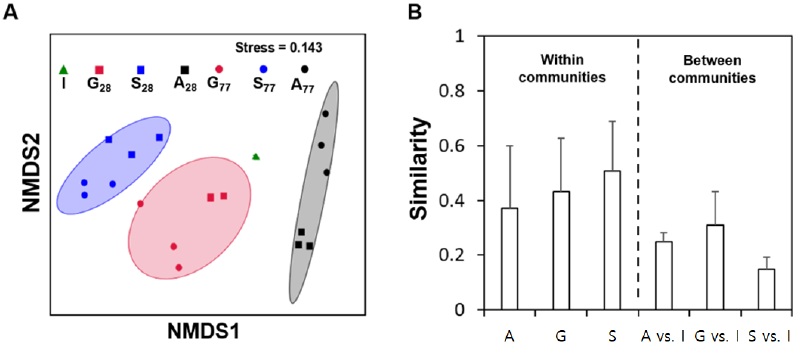
Figure 2. Shifts in the community structure over time. A nonmetric multidimensional scaling plot ( A ) was constructed based on the Bray-Curtis distance metric using the OTU composition data. Six communities developed with a carbon source were grouped within a 68% confidence ellipse. Each of the three groups developed with a carbon source (A, G, or S) differed in community structures from I ( p < 0.05 by the PERMANOVA test). Community similarities within and between communities ( B ). The community similarities were evaluated within the communities (A, G, and S, respectively) and between the communities (A vs. I, G vs. I, and S vs. I, respectively). The error bars indicate one standard deviation from the mean.